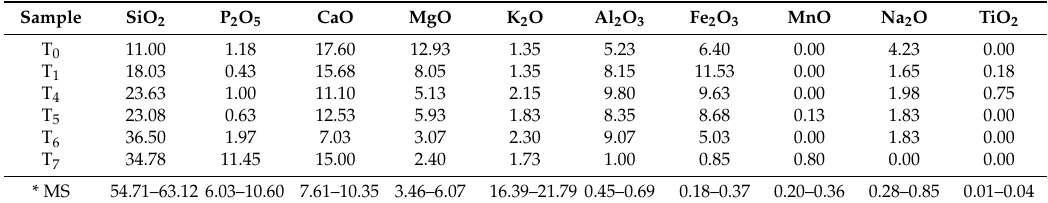
Table 5. Effect of hydrothermal carbonization hydrothermally carbonized (HTC) on the chemical composition of ash.